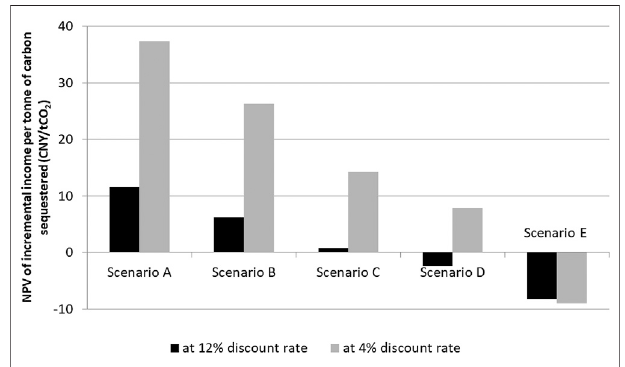
FIGURE1| NetpresentvalueofincrementalincomepertCO 2 indifferent destocking rate scenarios and at two discount rates (Chinese Yuan per tonne of carbon dioxide, CNY/tCO 2 ).